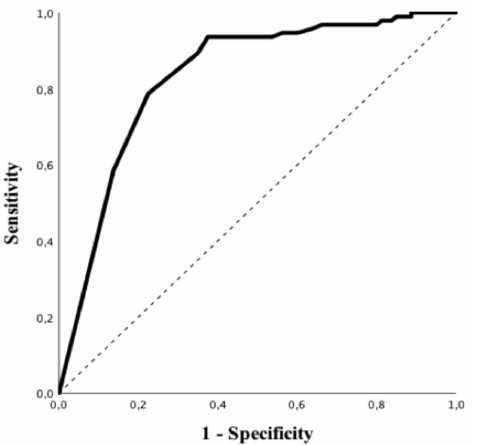
Figure 2. Receiver operating characteristic (ROC) curve of eosinophils counts to predict positive rRT-PCR test for